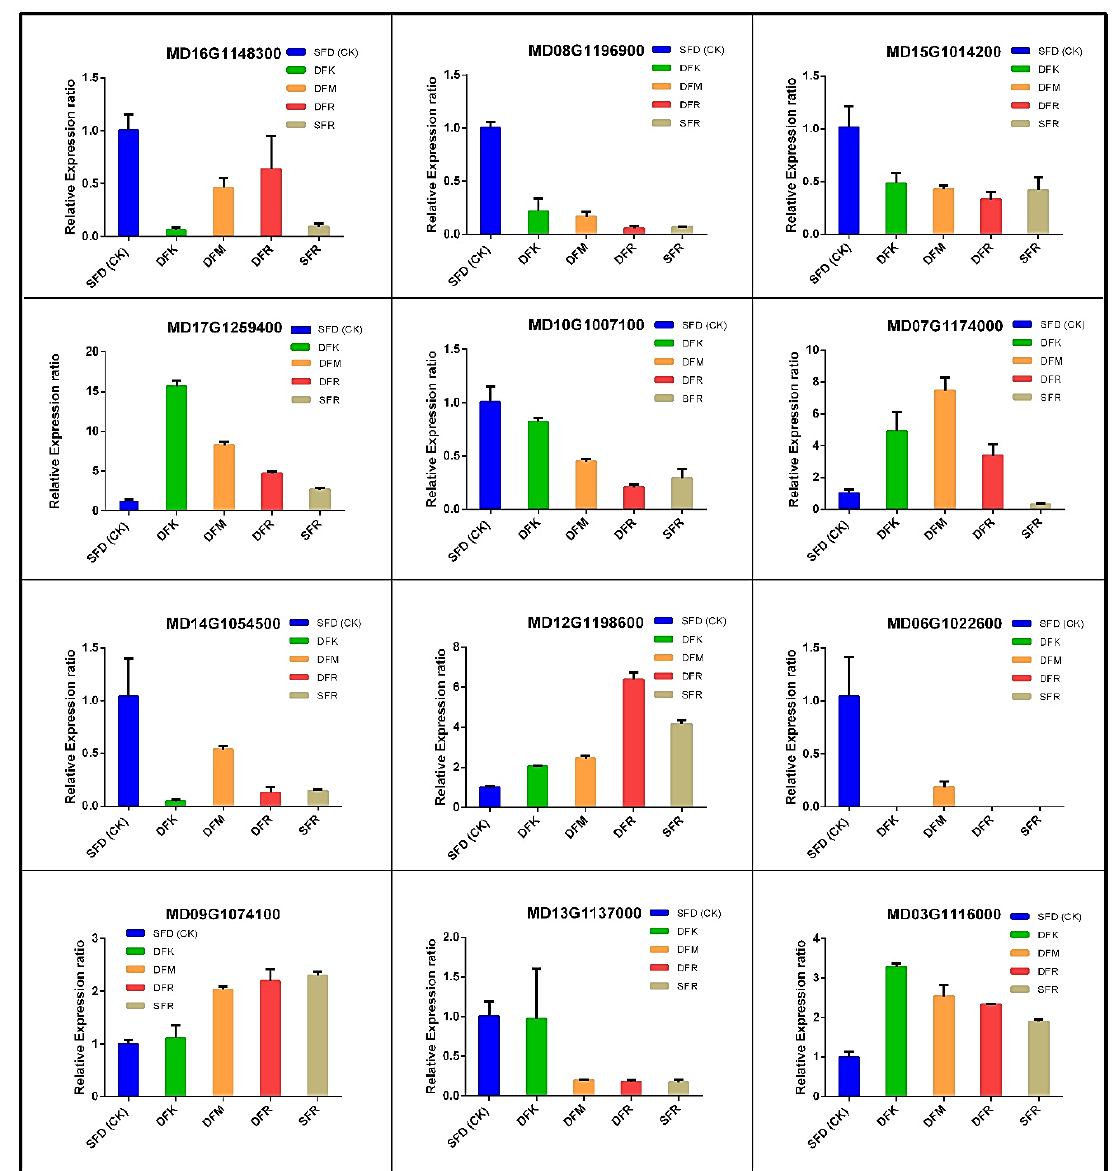
Figure 9. Real-time quantitative PCR validation profiles of 12 randomly selected genes from flowers of different varieties of apple along with single and double flowers from same tree; the data was normalized by using actin as an internal reference. Data are represented as mean ± SD for three biological replicates.